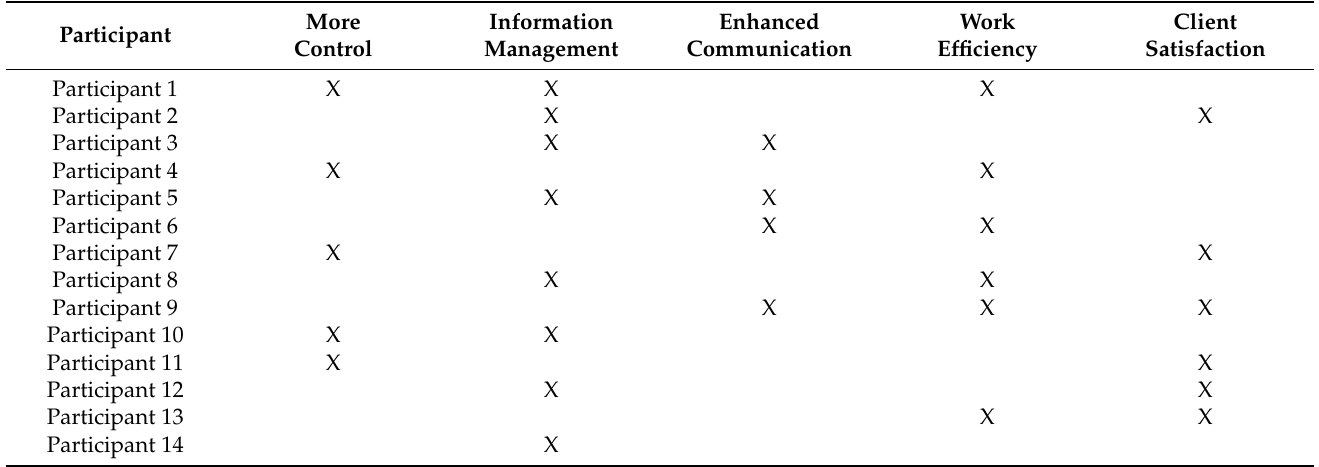
Table 2. Perceived benefits from the broader use of